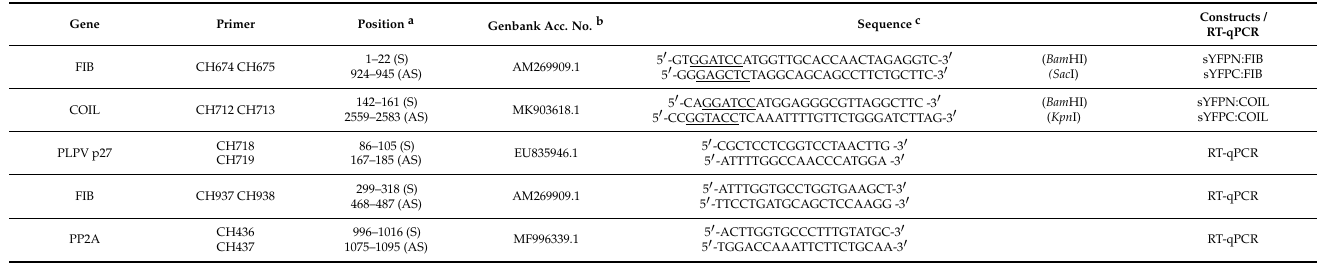
Table 1. List of primers used in this